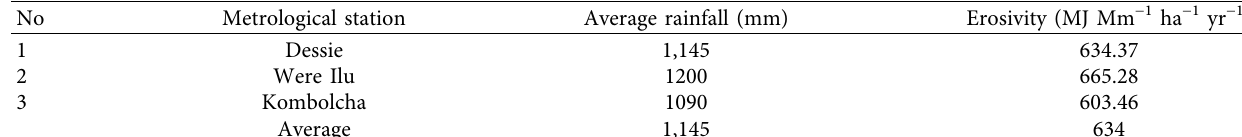
Table 1: Te average rainfall and erosivity.